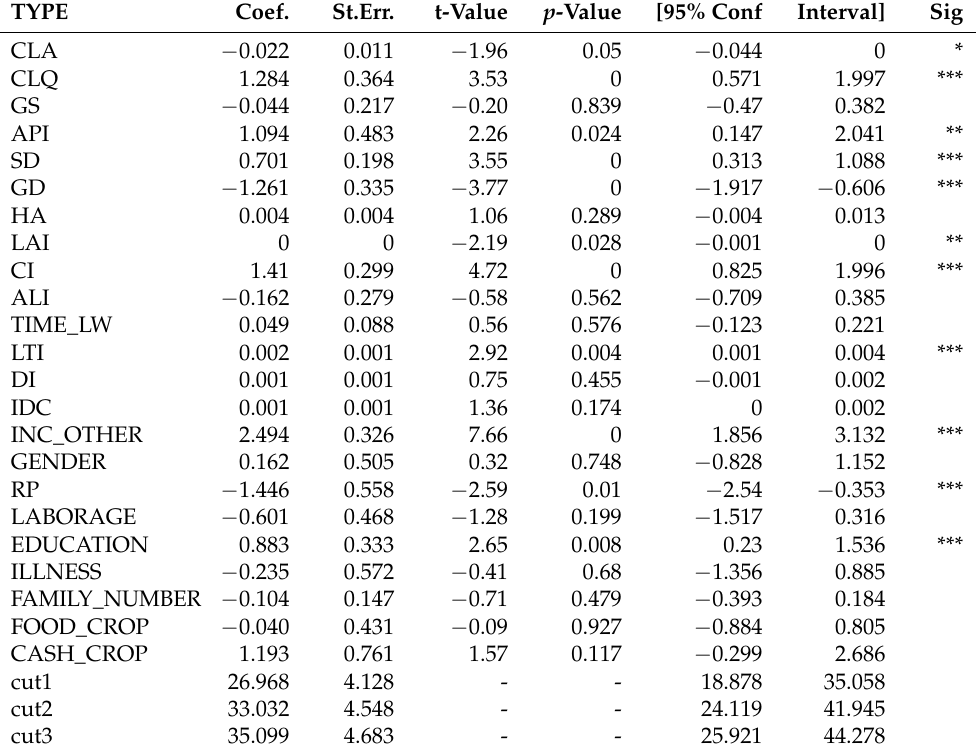
Table 3. Results of relative poverty groups ordered logistic regression